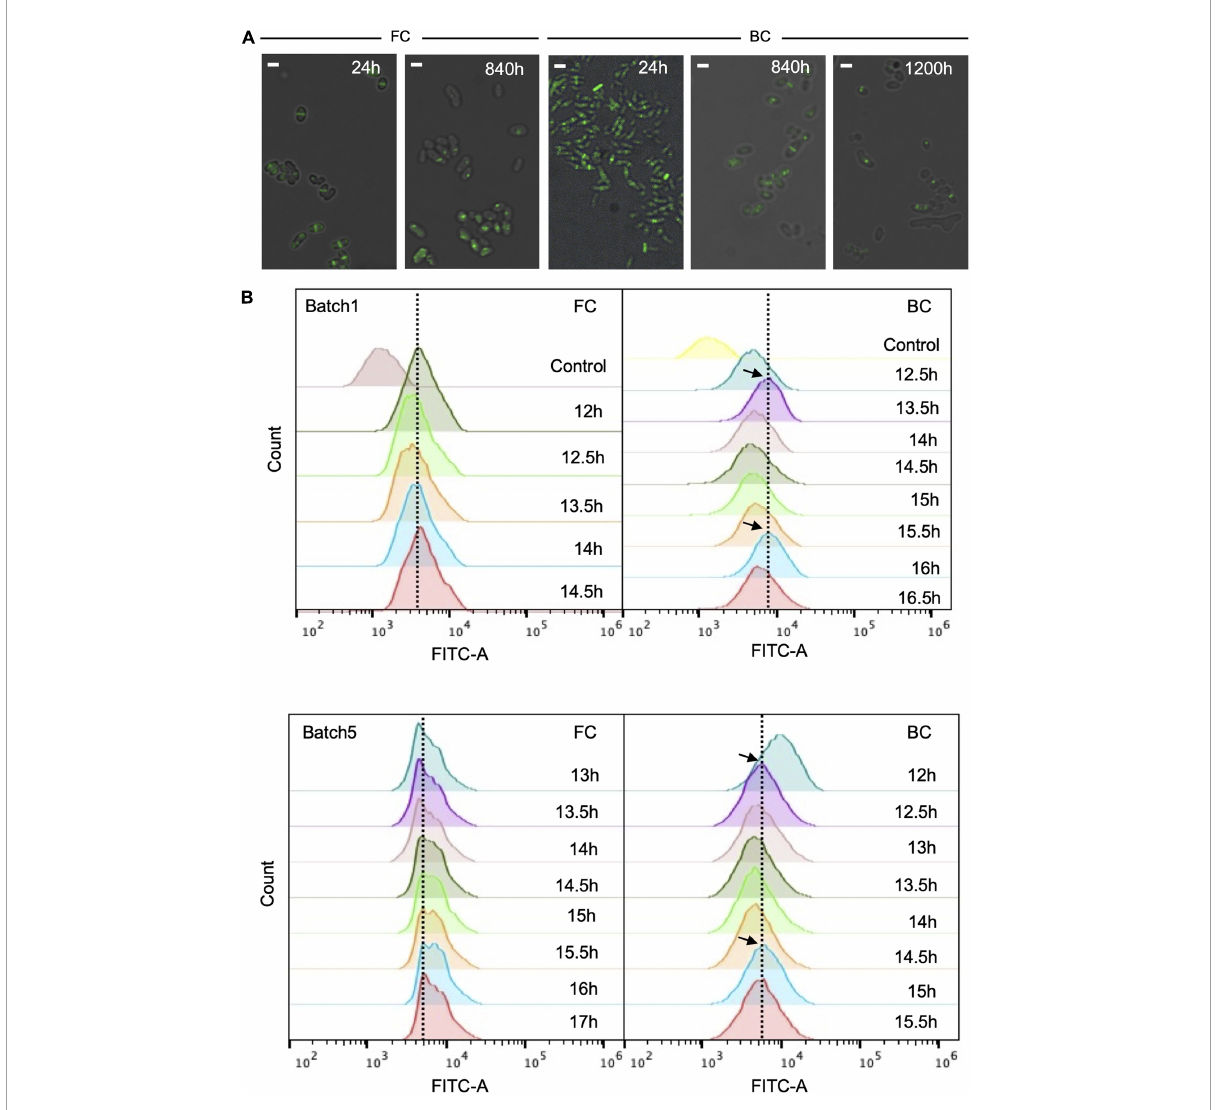
FIGURE3 Fluorescence of C. glutamicum ATCC13032- (FtsZ-EGFP) cells during long-term repeated-batch fermentation. (A) The fluorescence pictures overlapped with bright field pictures. BC, biofilm cells; FC, free cells. The fluorescent septa or foci indicate the formation of Z-rings at different time points. Scale bar, 2 µ m. (B) Fluorescence intensity histograms of flow cytometry analysis. Cells were analyzed at the exponential growth phase (12–17 h) of each batch. The black arrows indicate possible oscillations in fluorescence intensity of biofilm cells. Fluorescence intensity of wild C. glutamicum ATCC13032 without EGFP fusion was used as